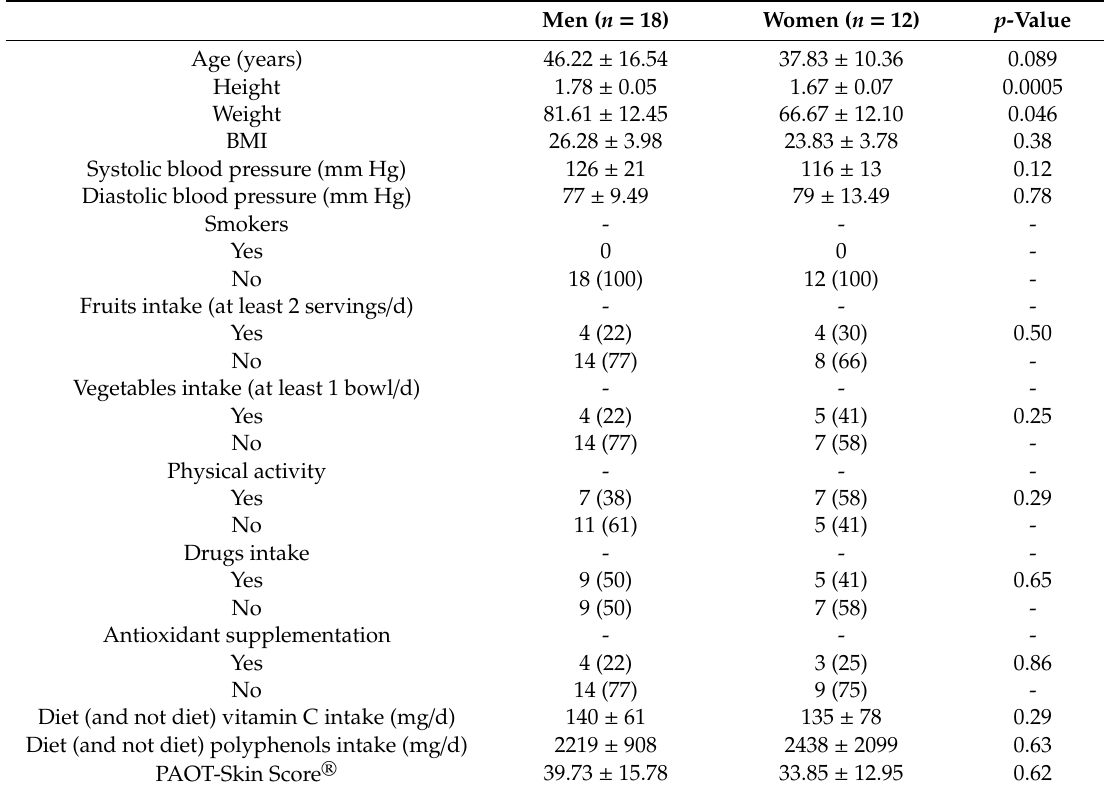
Table 4. Gender-specific demographic, biometric, medical, and dietary characteristics of the 30 volunteers participating to the study for evaluating relationship between PAOT-Skin Score ® and of OS biomarkers (Group VI).